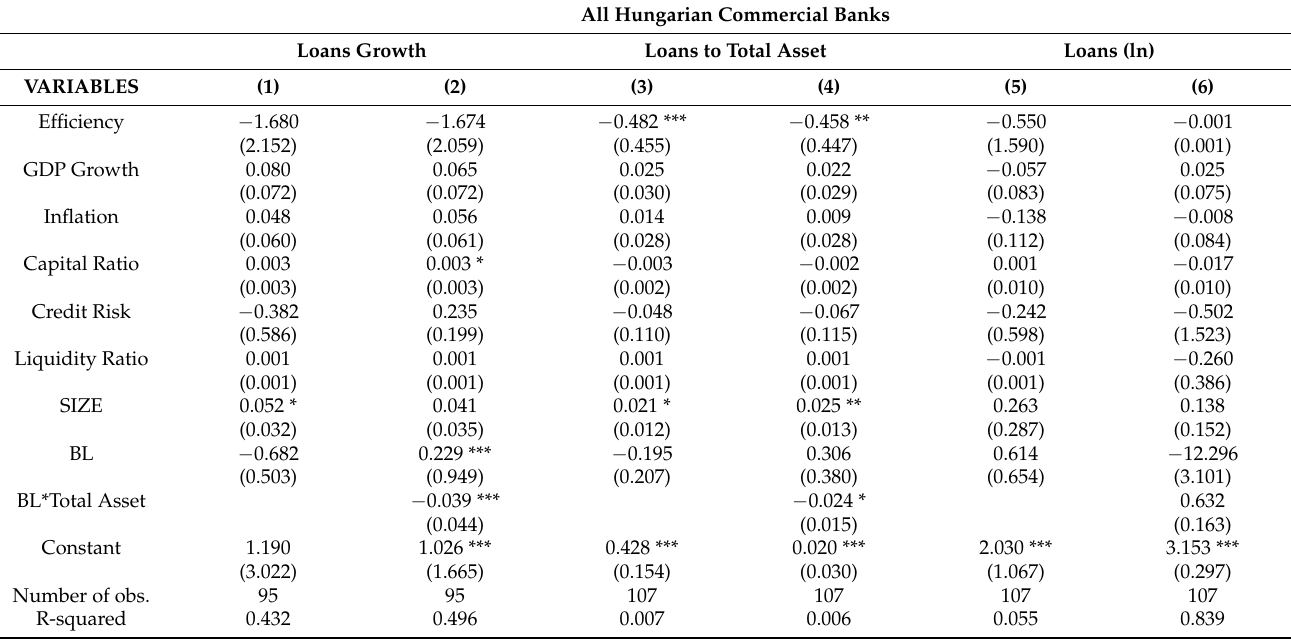
Table A2. Data presenting estimates based on GLS regressions with a random effect on all Hungarian commercial banks. Symbols *, **, and *** represent statistical significance at the levels of 10%, 5%, and 1%, respectively.